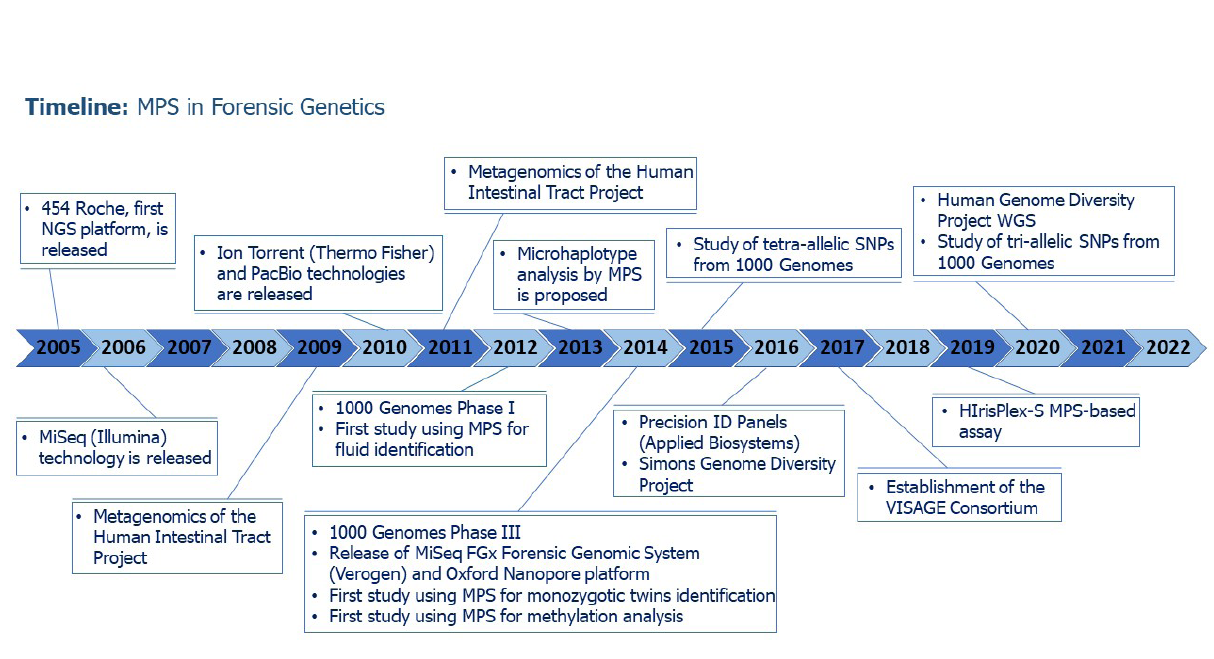
Figure 1 – Major advancements in forensic genetics related to MPS